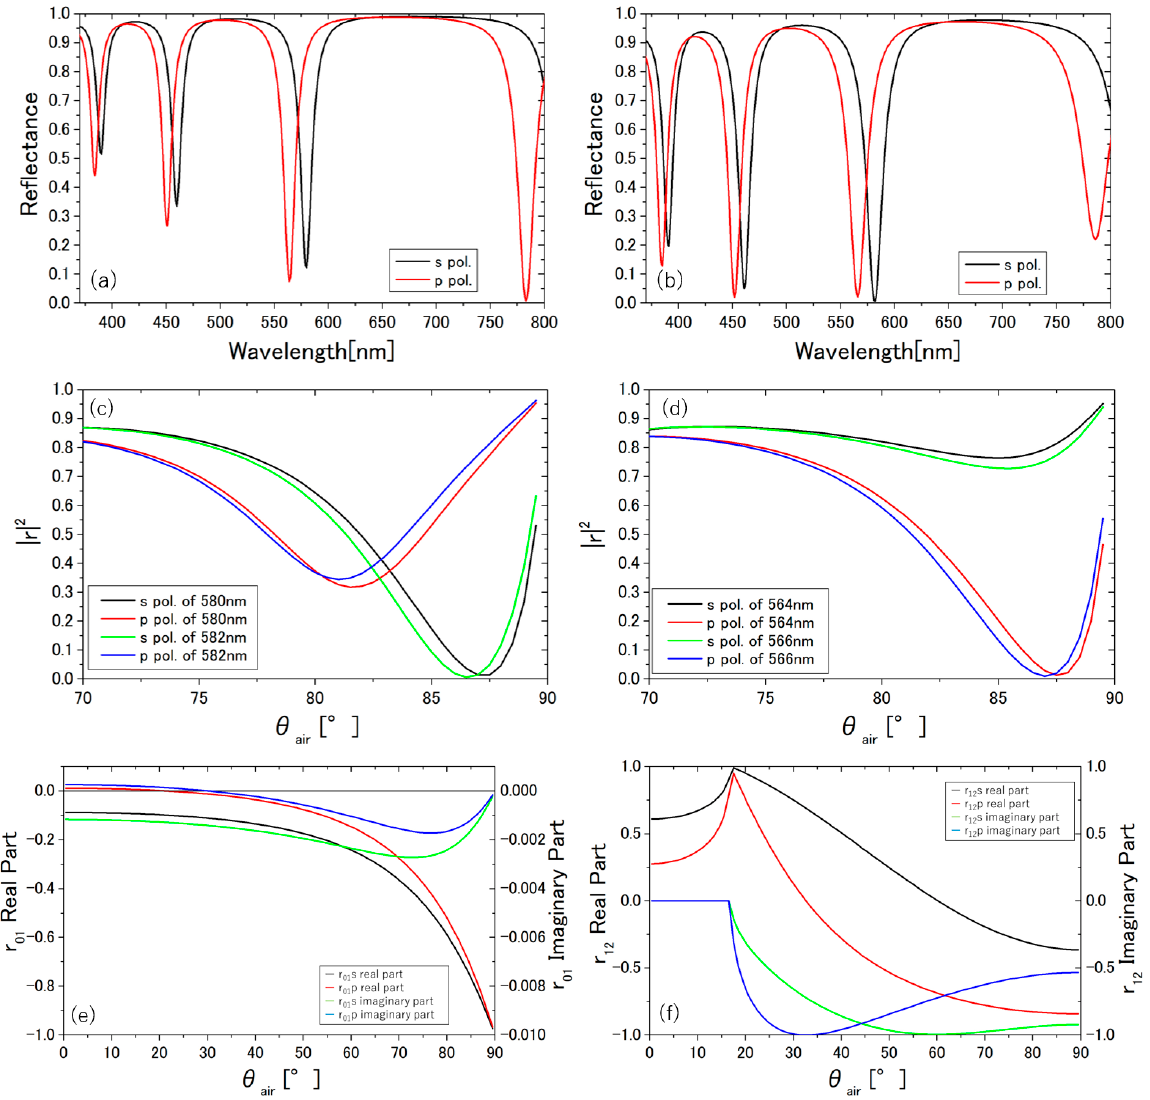
Figure A1. The calculated incidence angle dependence of the reflection. The reflectance | r | 2 spectra of p- and s-polarized light at the incidence angle of ( a ) θ air = 88.5 ◦ ( θ 0 = 88.92 ◦ ) and ( b ) θ air = 86.5 ◦ ( θ 0 = 87.83 ◦ ). The wavelength of the dip shifts with the incidence angle. ( a ) The deepest dip is 99. 28% at 783 nm for p-polarization. Between 550 and 600 nm, there are dips of an 87.77% depth at 580 nm for s-polarization and of 92.50% at 564 nm for p-polarization. ( b ) For s- and p-polarization, the deepest dip of a 99.41% depth at 582 nm and of 97.98% at 452 nm, respectively. The 580 and 564 nm dips at θ air = 88.5 ◦ are shifted to 582 (99.41%) and 566 nm (97.86%) at θ air = 86.5 ◦ . The incidence angle ( θ air ) dependence of the reflectance | r | 2 of s- and p-polarization ( c ) at 580 and 582 nm and ( d ) at 564 and 566 nm. The incidence angle ( θ air ) dependence of the real and imaginary parts of ( e ) r 01S,P and ( f ) r 12S,P at 564 nm.